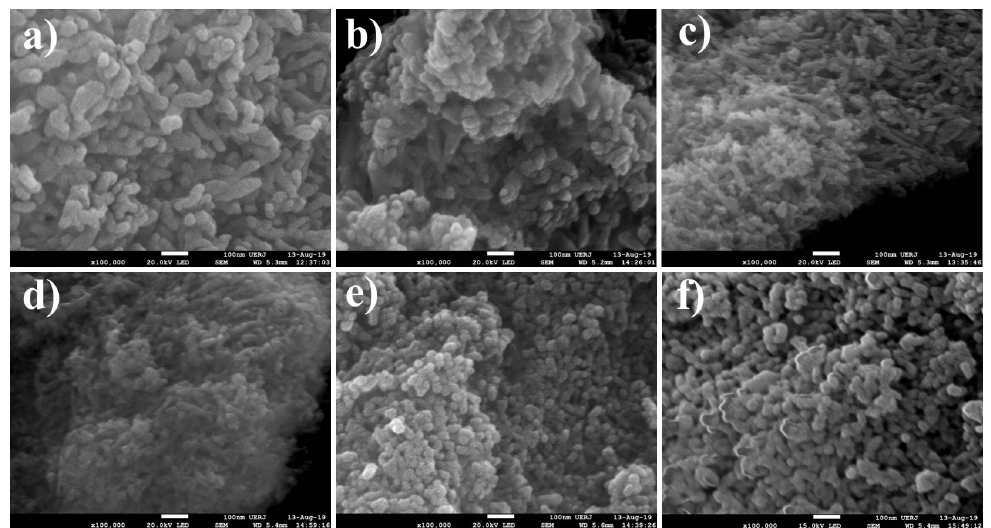
Figure 6. SEM micrographs of the (a) HAp-600, (b) HAS0.5-600, (c) HAS1-600, (d) HAS2-600, (e) HAS3-600 and (f) HAS4-600 samples.